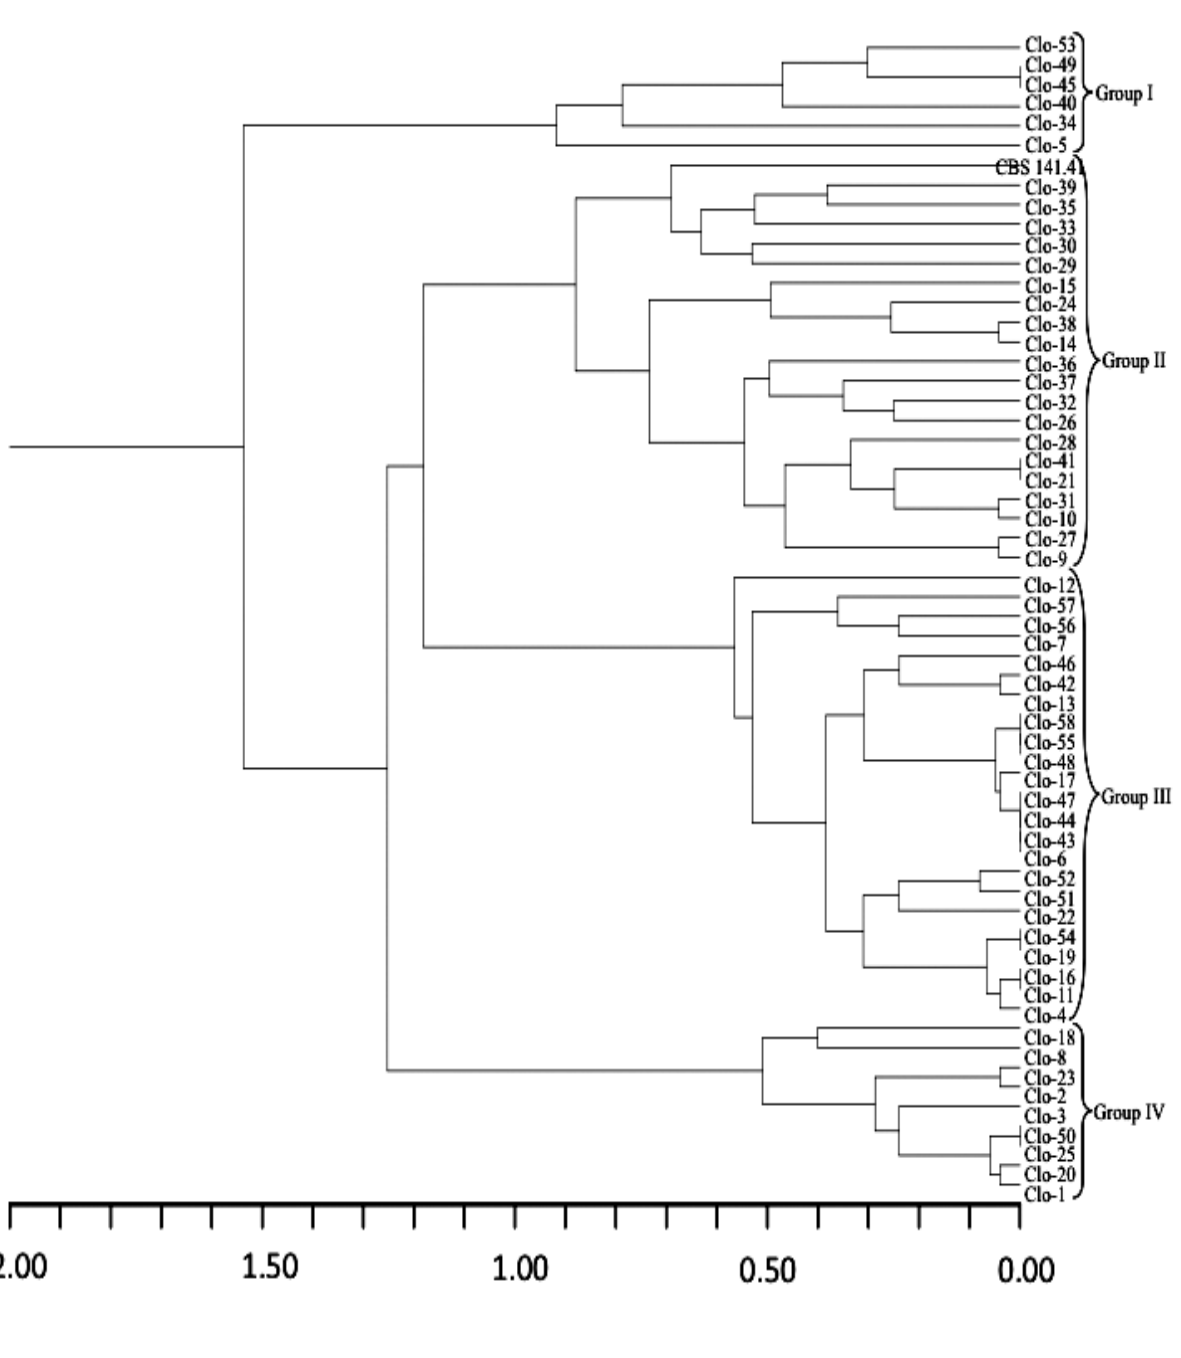
Figure 3. Dendrogram showing phenotypic relatedness, based on morphological and colony characters of 59 Cadophora luteo-olivacea isolates. Cluster analysis was performed using the Unweighted pair group with arithmetic average method in the NCSS program. The correlation cophenetic value ( r ) was 0.9419.